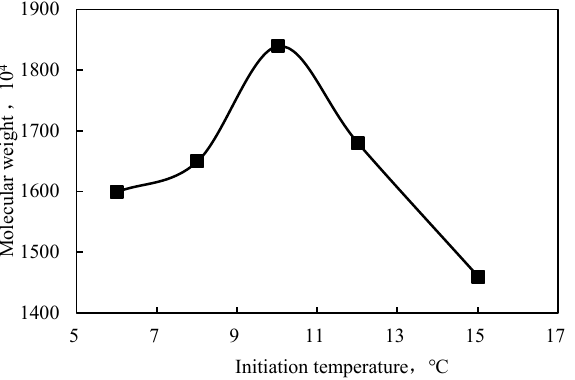
Figure 3. Effect of the initiation temperature on the molecular weight of the intercalated polymer.